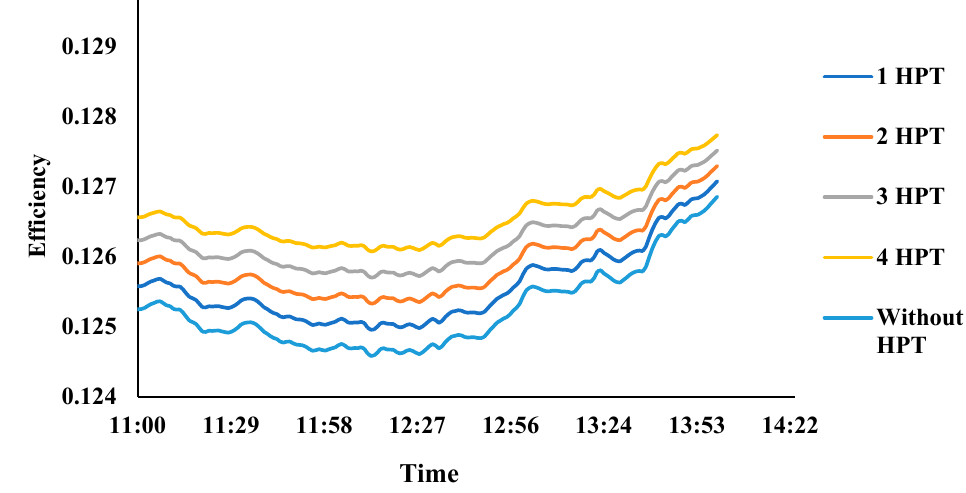
Figure 8. Panel temperature efficiency variation with time for different number of heat pipes .